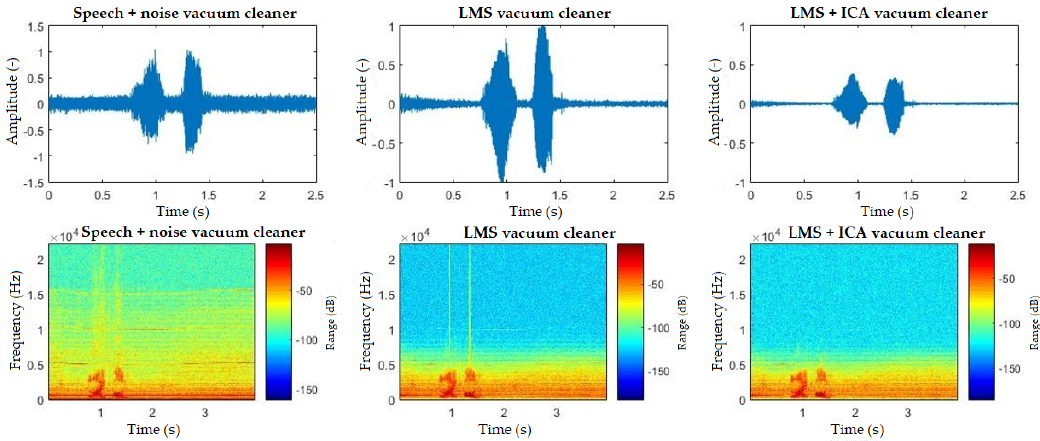
Figure 11. Comparison of spectrograms with closed windows, “light on” command, vacuum cleaner interference.